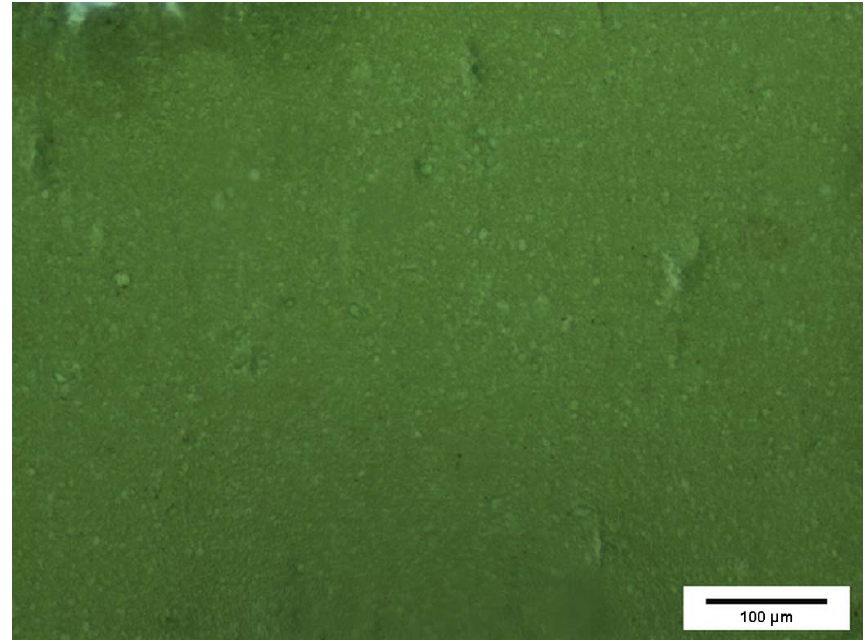
Figure 5. Negative sample of processed cheese, lectin histochemistry, background staining B-Calleja (green—protein).